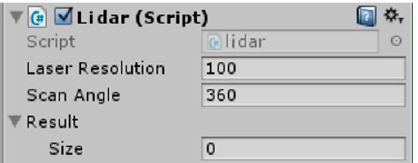
Figure 4. Programming page of the 2D LiDAR script.